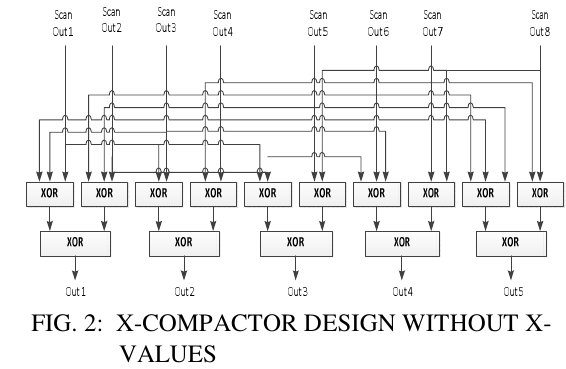
FIG. 2: X-COMPACTOR DESIGN WITHOUT X-